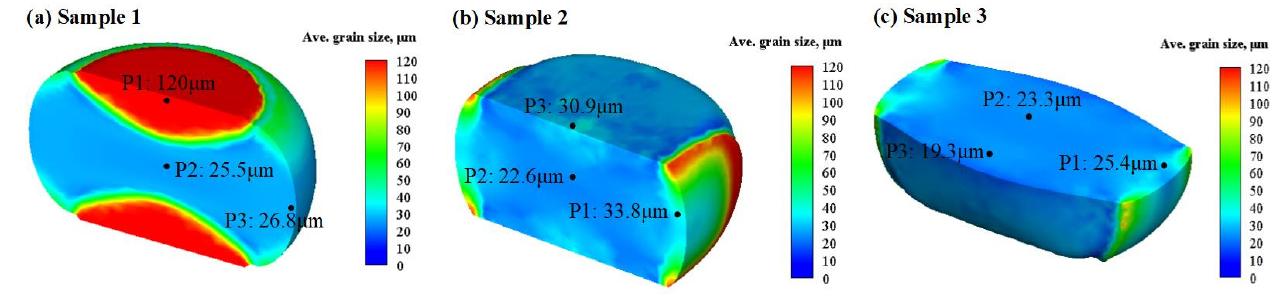
Figure 9. Average grain size of ( a ) Sample 1; ( b ) Sample 2; ( c ) Sample 3 at different tracking points obtained from FEM results.